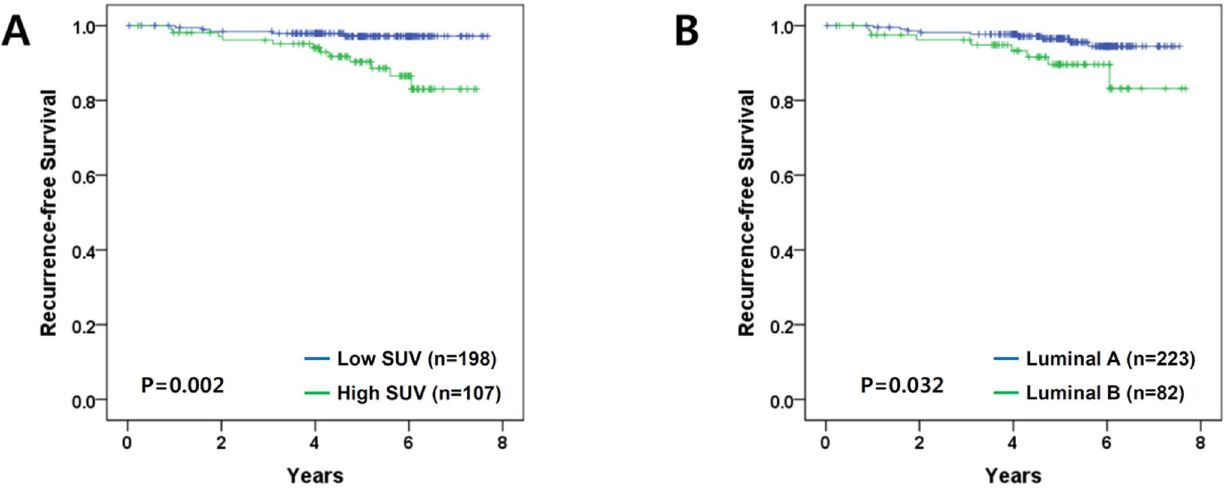
Figure 2. Kaplan-Meier plots for recurrence-free survival. All P -values are calculated by the log-rank test (A) Stratification by SUV max ( P =0.002) (B) Stratification by the intrinsic subtypes ( P =0.032).